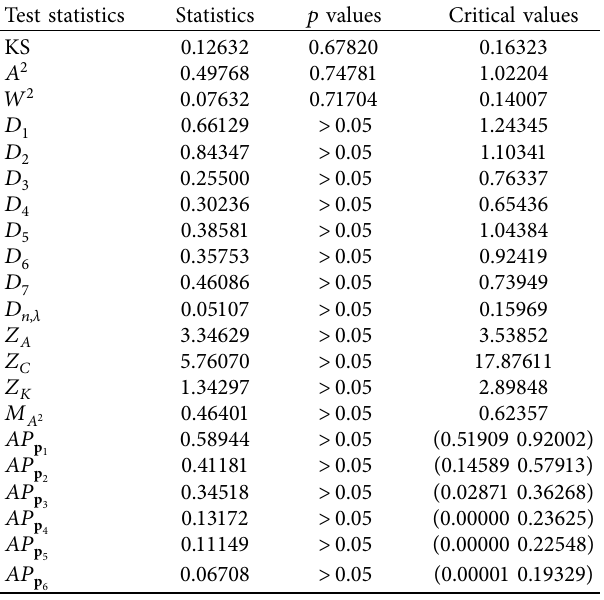
Table 4: Test statistic and corresponding p values from real data.